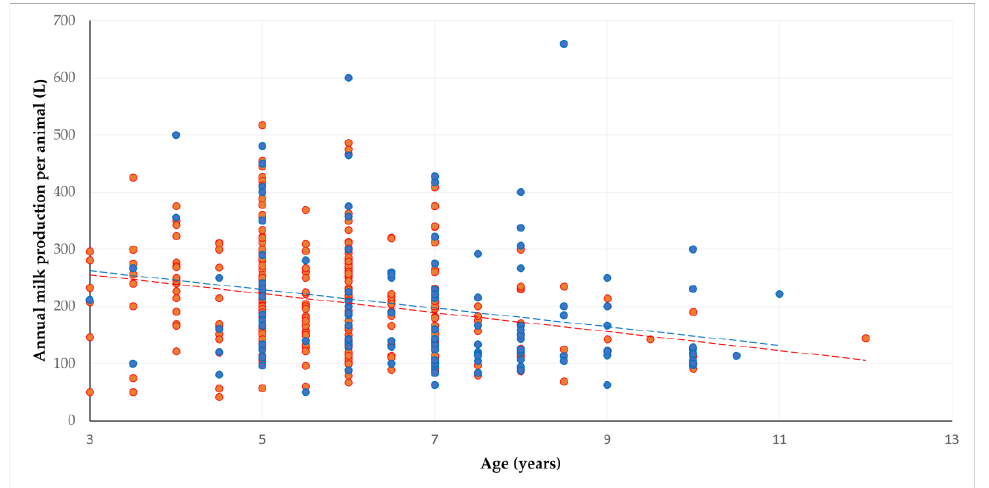
Figure 4. Inverse correlation between age in which adult animals were replaced, and milk production (red dots: sheep farms, blue dots: goat farms; dashed lines indicate respective trendlines).